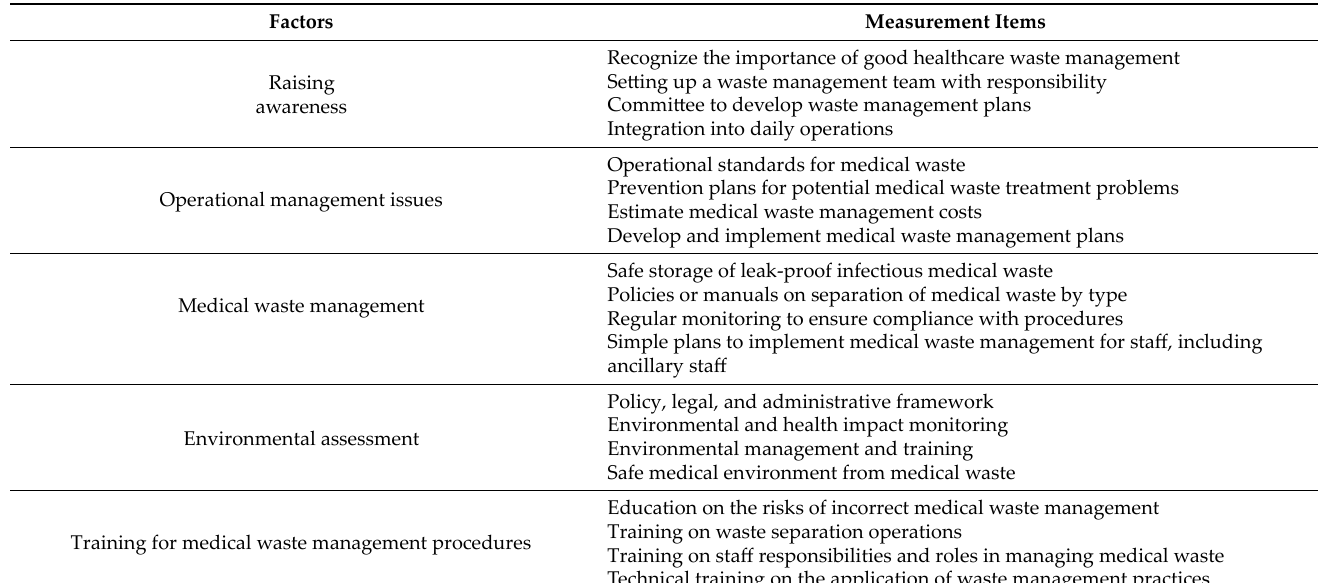
Table 3. Measurement items for this